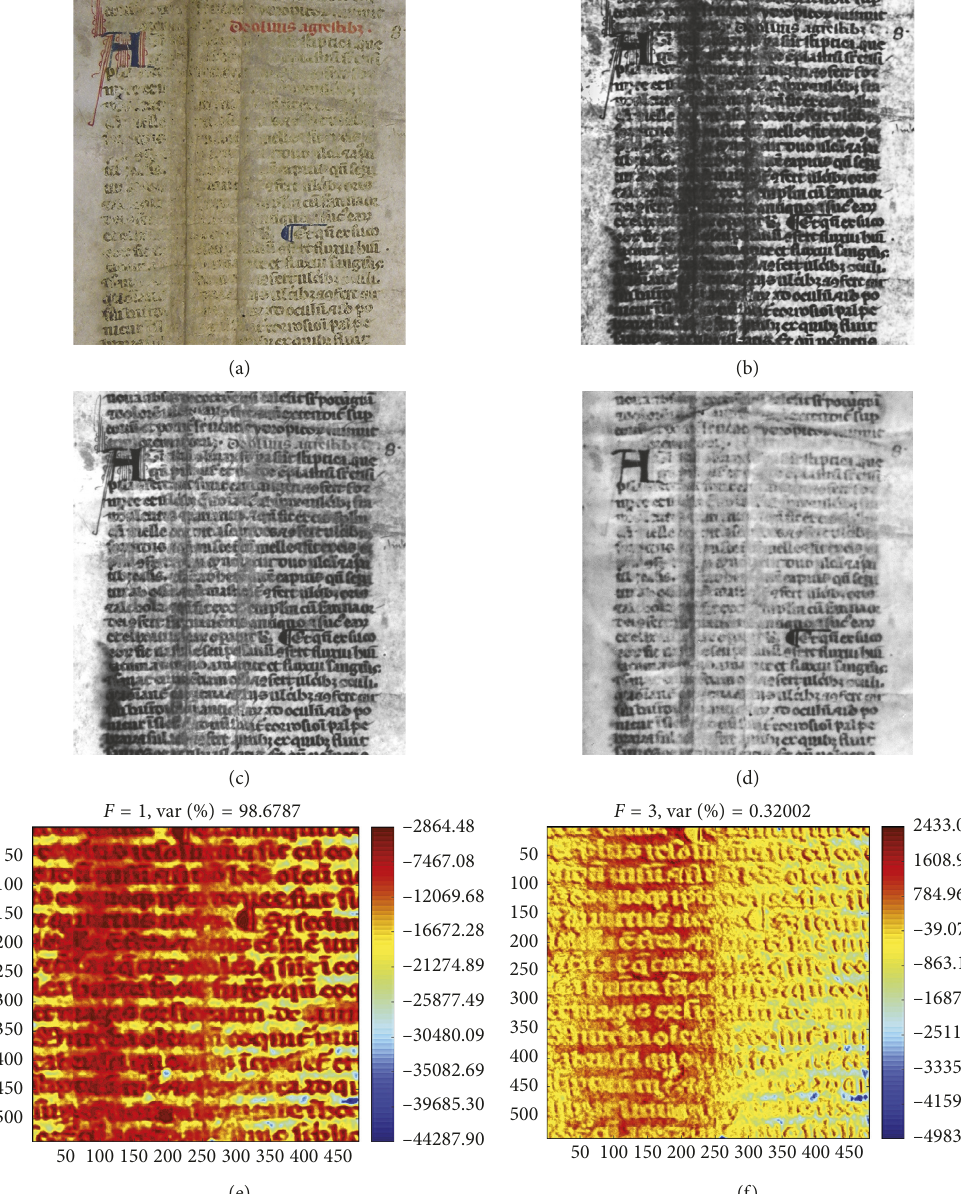
Figure 7: Photography (a) and UV fluorescence images taken at 420nm (b), 680nm (c), and 800nm (d) of details of Parch. 34. (e, f) Image processing results by PCA: score image of PC1 (variance 98.68%) and score image of PC3 (variance